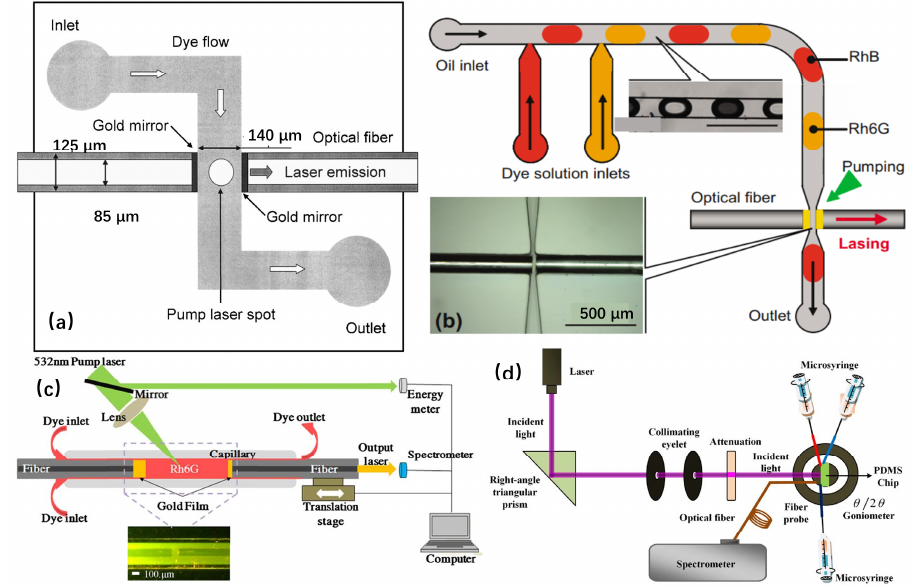
Figure 5. Schematic diagram of a microcavity laser based on an F-P cavity. ( a ) On-chip co-linear two-color microfluidic dye laser [47]; ( b ) Fast-switching microcavity laser with two different dye droplet streams [48]; ( c ) Laser wavelength tunable microcavity laser [49,50]; and ( d ) White dye laser [51].